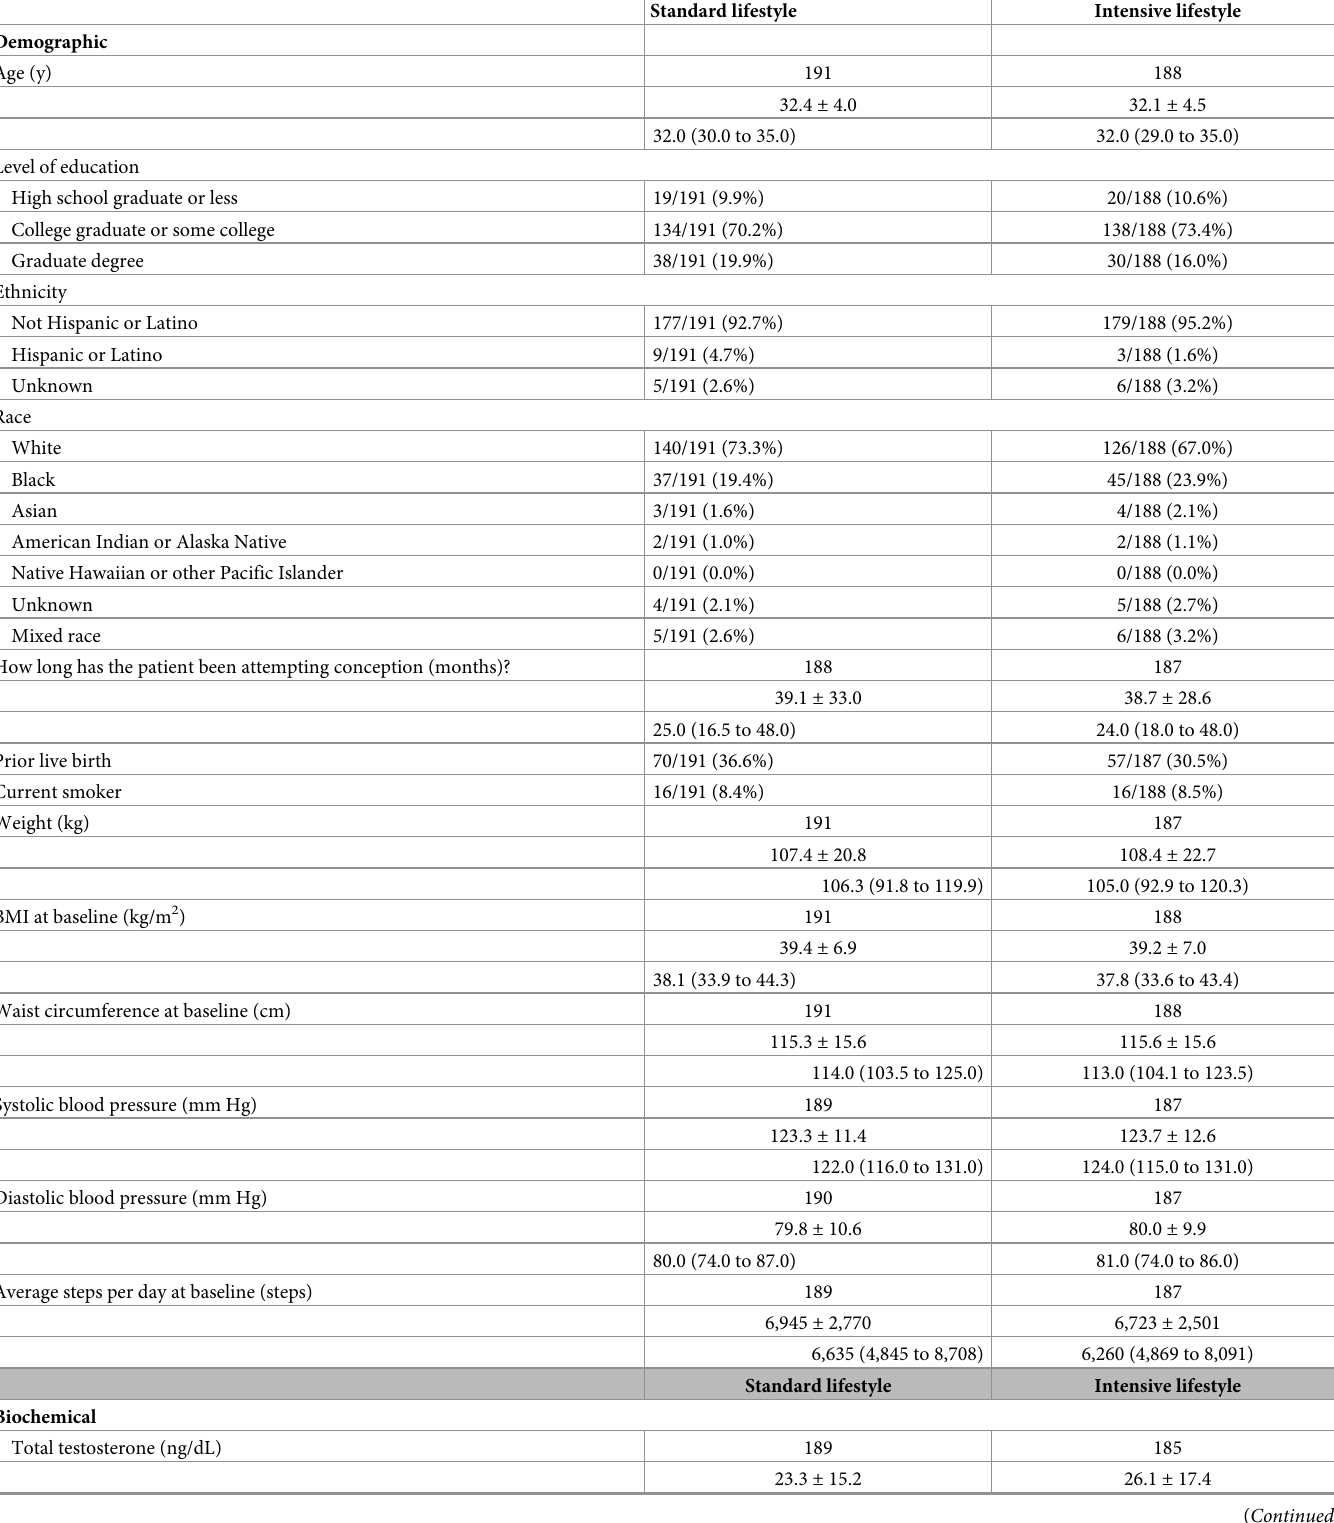
Table 1. Baseline characteristics of the